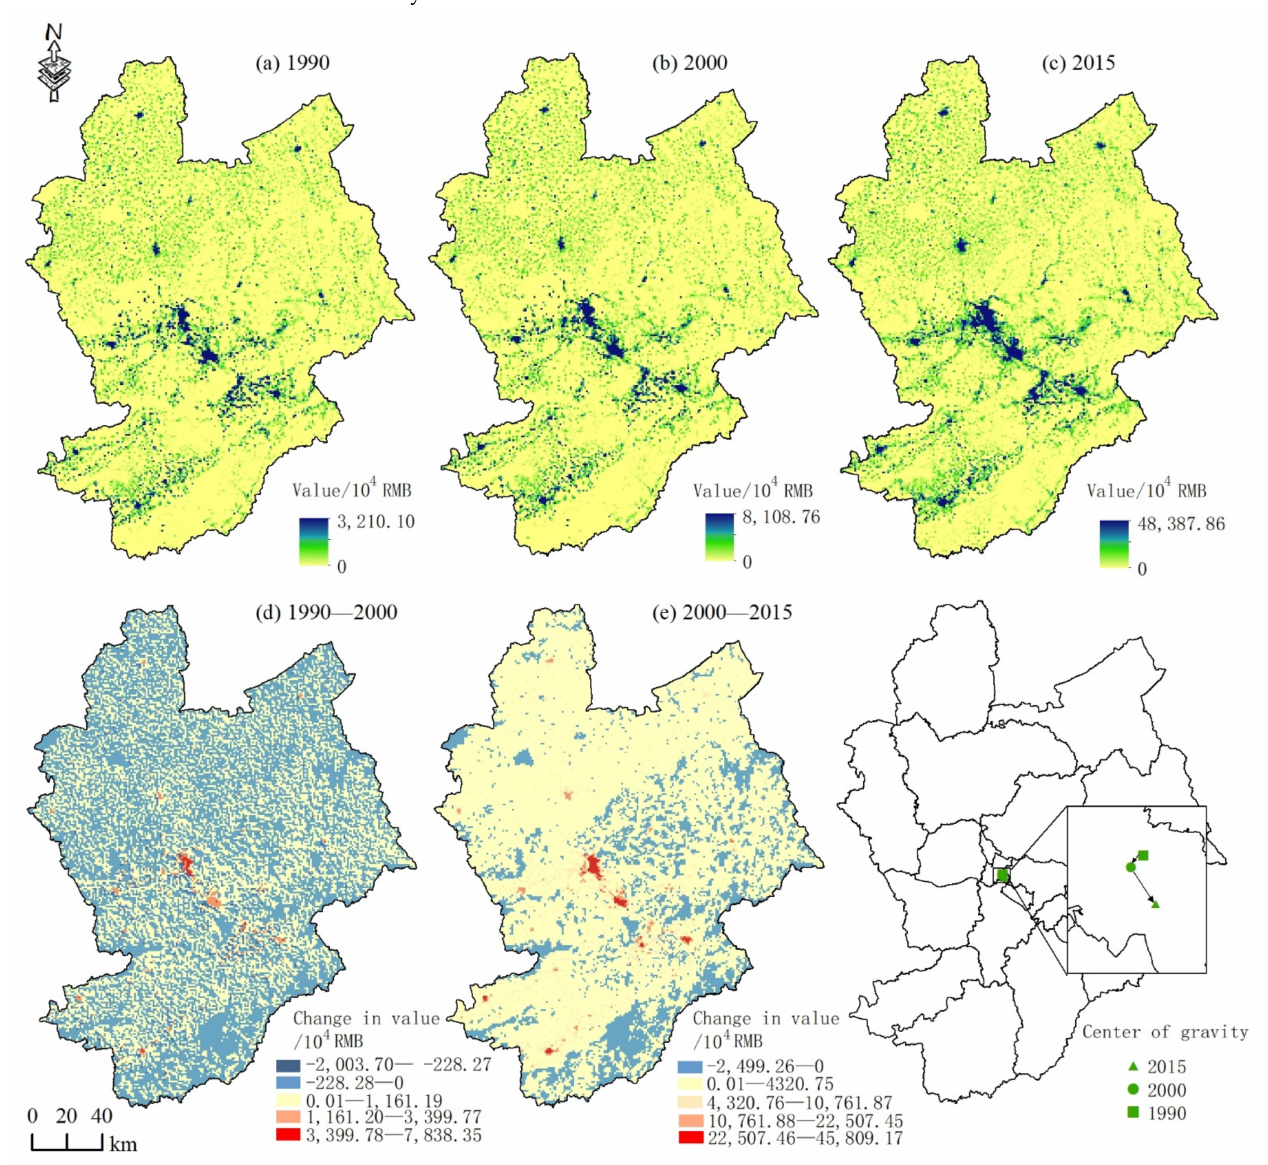
Figure 4. Spatial evolution of land use social function at grid scale in Zhangjiakou City in